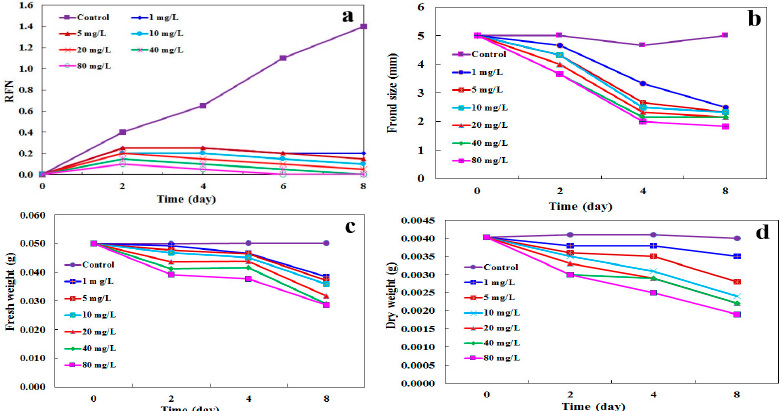
Figure 4. The influence of increasing concentrations of CdSe NPs on the growth parameters of Lemna minor. ( a ) Relative frond number (RFN), ( b ) frond size, ( c ) fresh weight, and ( d ) dry weight on the 2nd, 4th, 6th, and 8th days after treatment. Experimental conditions: 1 g of plant in 200 mL of nutrient solution (for each time and concentration treatment), temperature ≈ 25 °C, pH = 6.5–7, 16/8 (light/dark) photoperiod. The level of confidence is 95% according to Tukey Test ( n = 3 replicates).